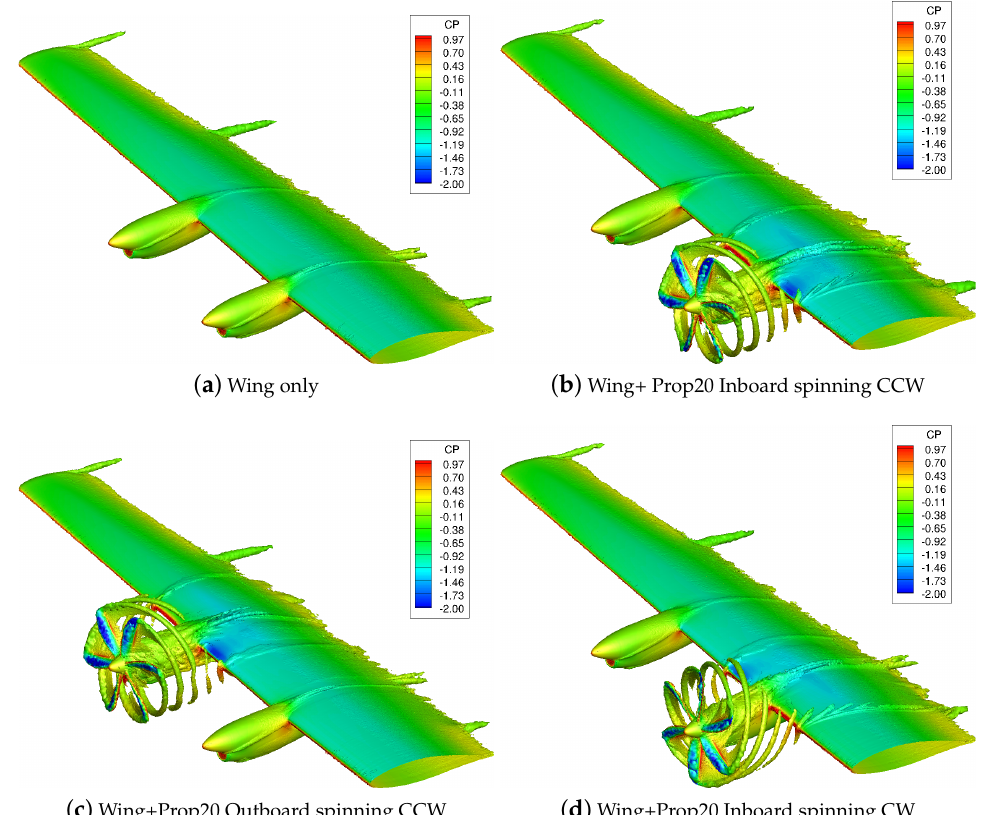
Figure 8. Propeller installed inboard/outboard; vorticity isosurfaces are colored with pressure coefficients. Propellers have a 20-deg blade angle and spin at 1024 rpm. Wing only solution is time-averaged for the final three seconds of simulations. Wing+Prop solutions are at the final simulation time.